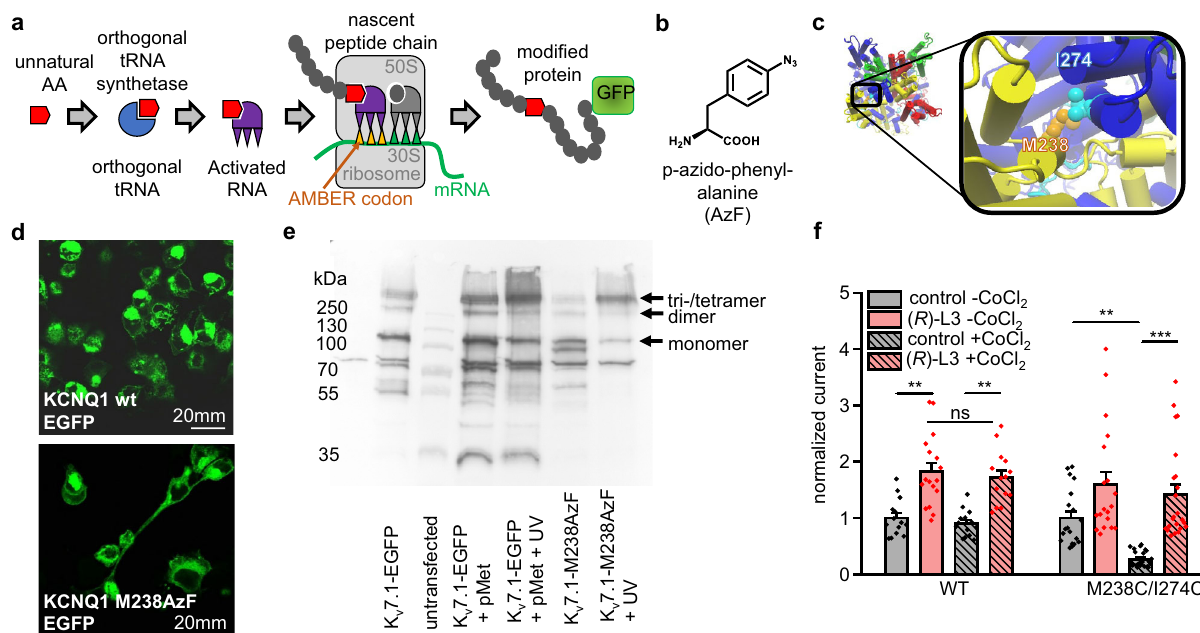
Fig. 5 Photo-crosslinking of the photo-activatable non-canonical amino acid AzF leads to formation of multimers. a , b Using the amber suppression methodology for incorporation of non-canonical amino acids (ncAAs), we introduced the photo-activatable non-canonical amino acid AzF ( b ) at M238 position into mutant K v 7.1-EGFP-M238AMBER-Stop. HEK cells were co-transfected with cDNA encoding K v 7.1-EGFP-M238amber-Stop, suppressor tRNA and AzF-tRNA synthetase. Addition of the ncAA p -azido-phenylalanine (AzF) at 0.5 mM to the cell culture medium allowed for incorporation of the ncAA. c I274 interacts with M238 from the adjacent subunit in activated state in silico . d Successful incorporation and full-length protein expression was assayed by confocal EGFP imaging. e K v 7.1-EGFP-M238AzF expressing HEK cells were incubated in high K + solutions (137 mM KCl) leading to channels preferentially in depolarized (calculated V m of about − 8.9 mV) states. UV irradiation caused formation of multimers under high K + / preferentially depolarizing conditions consistent with the predicted interaction. f Normalized currents of hK v 7.1 WT and hK v 7.1 M238C/I274C expressing oocytes in the absence and presence of ( R )-L3 and Co 2 + ions (number of oocytes for each condition see SI Table